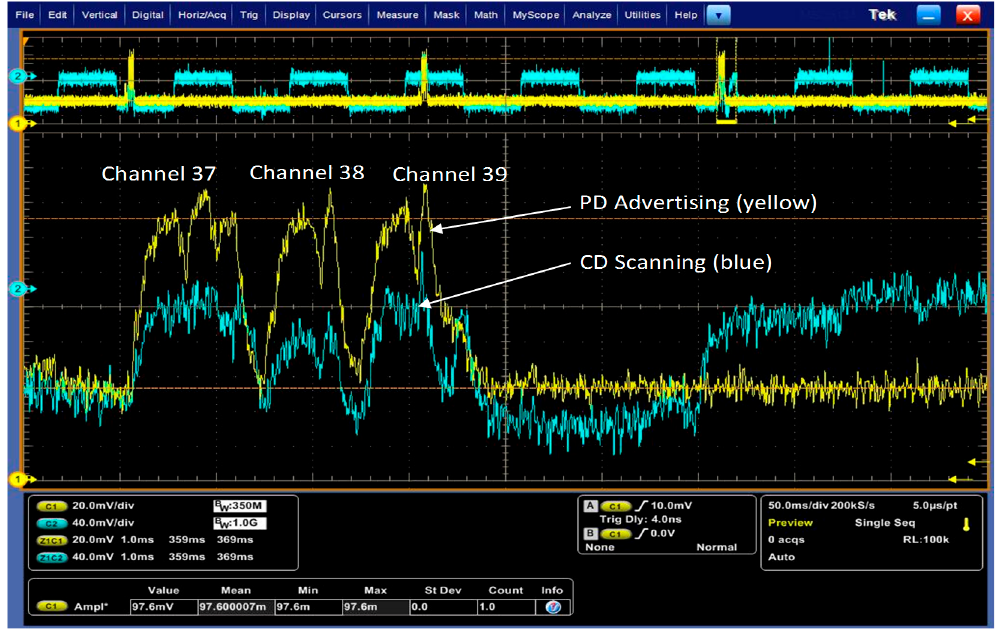
Figure 3. Advertising event waveform for Intel A-101.